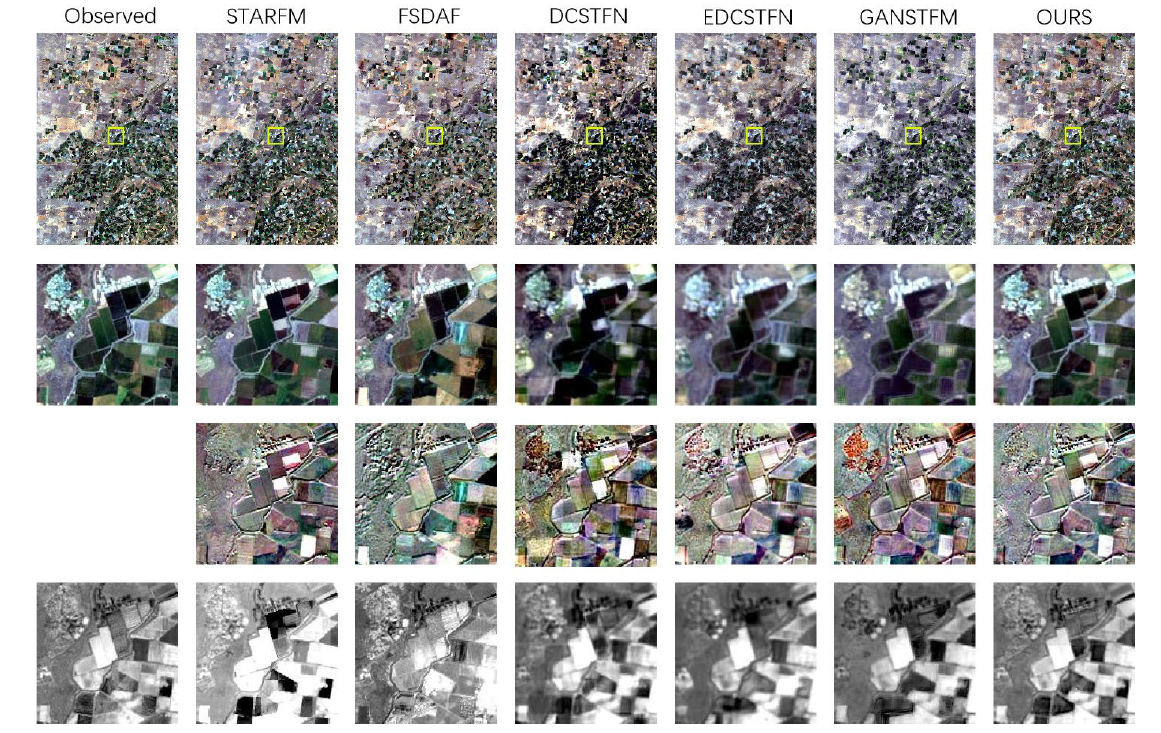
Figure 8. Show the results in a partial enlargement of the CIA dataset. (Each column in the figure represents the predicted image of each model, “OURS” represents the MCBAM-GAN model, and “observed” represents the actual label.)